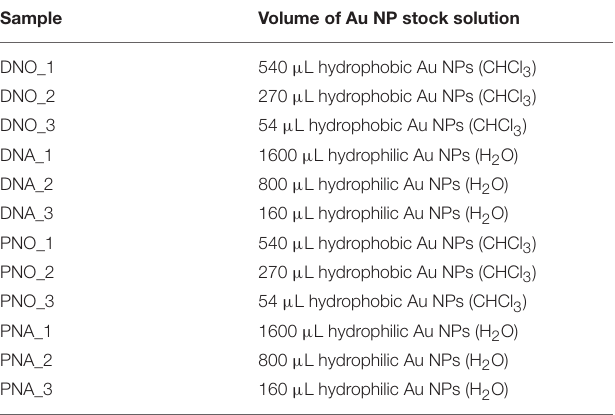
TABLE 1 | Volumes of Au NP stock solution used in each synthesis.